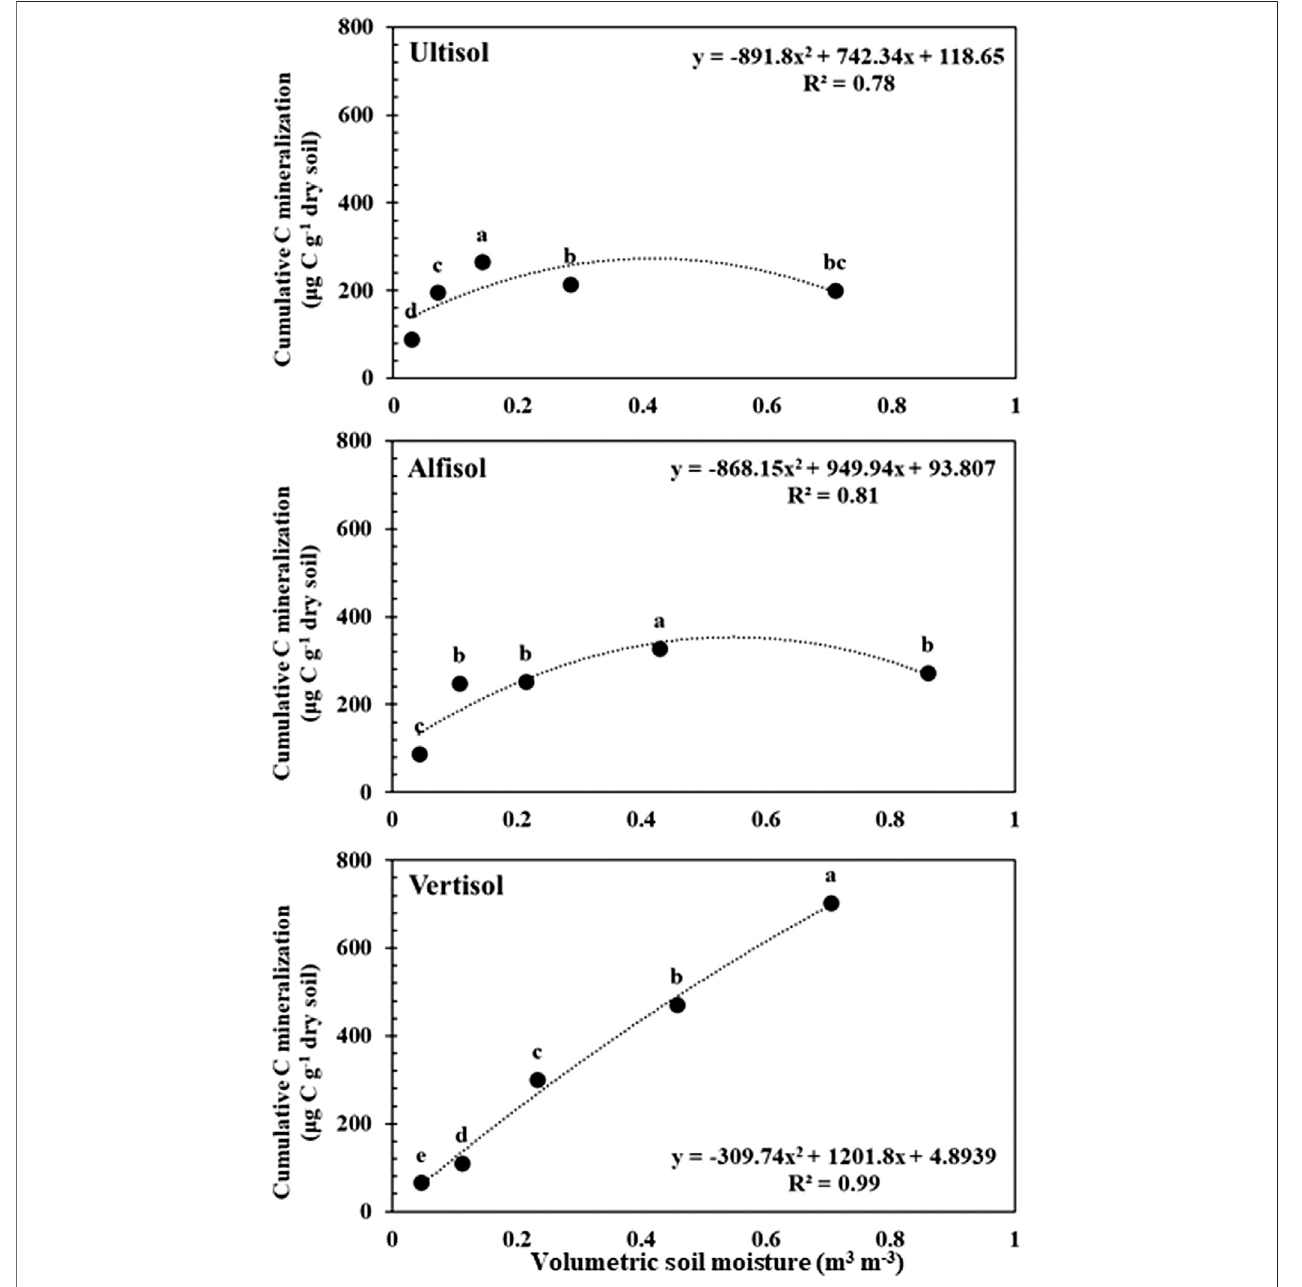
FIGURE 2 | Cumulative C mineralization per unit dry soil after day 90 from Ultisol (A) , Al fi sol (B) , and Vertisol (C) soils in response to increasing soil moisture. Error bars represent standard errors ( n (cid:1) 3). Different letters represent statistical signi fi cance at p < 0.05. The curves represent the second-order polynomial response of cumulative C mineralization to soil moisture